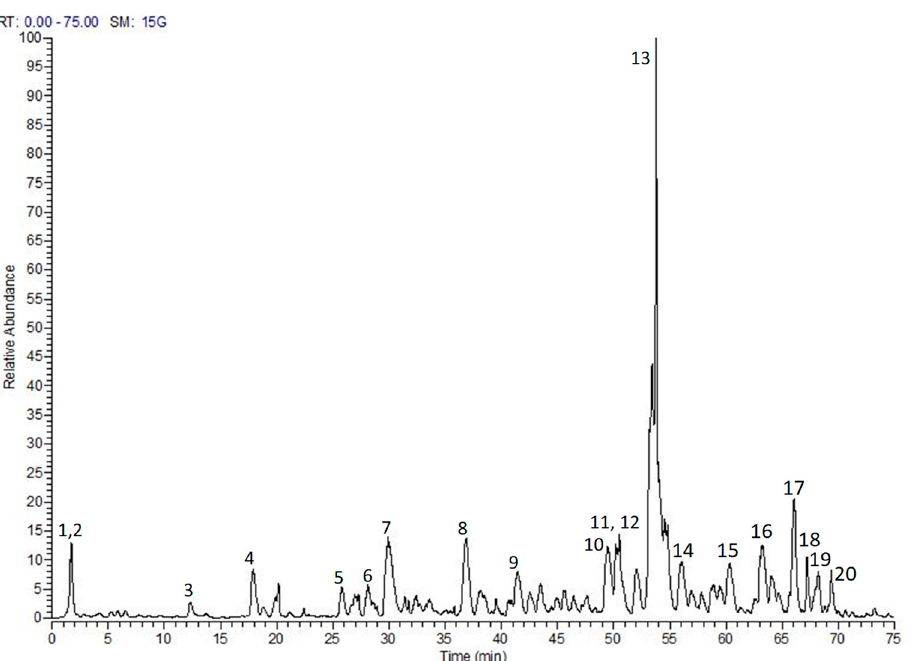
Figure 1. LC-MS/MS profile of S. samarangense leaves extract, adopted from Sobeh et al. [10]. (1) Quinic acid, (2) Hydroxyferuloyl malic acid, (3 and 4) (epi).Catechin-(epi)-gallocatechin, (5) (epi)-Gallocatechin-(epi)-catechin gallate, (6) Kaempferol glucoside, (7) (epi)-Gallocatechin gallate, (8) (epi)-Catechin-afzelechin, (9) (epi)-Catechin gallate, (10) Myricetin glucoside, (11) Myricetin pentoside, (12) (epi)-Catechin-(epi)-catechin-(epi)-catechin-(epi)-gallocatechin, (13) Myricitrin, (14) Procyanidin dimer monogallate, (15) Methyltricin, (16) Guaijaverin, (17) Isorhamnetin rhamnoside, (18) Mearnsitrin, (19) Myrigalone H pentoside, and (20) Quercetin galloyl-pentoside.